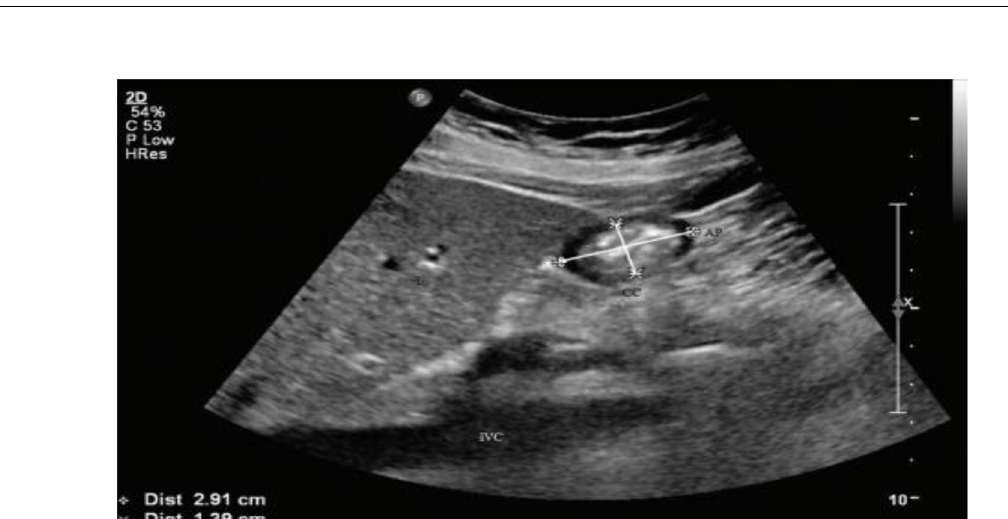
Fig. 1 Still image of the sagittal section of the Antrum during aperistalsis stage of the stomach for cross-sectional area